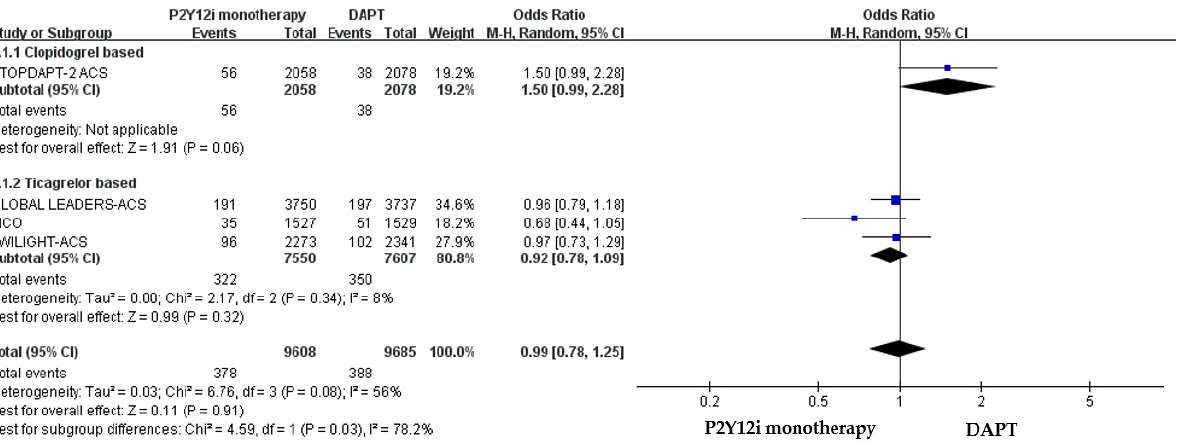
Figure 3. The efficacy outcomes (MACCE) of different P2Y12 inhibitor monotherapy as compared with 12-month DAPT in patients with ACS after PCI.